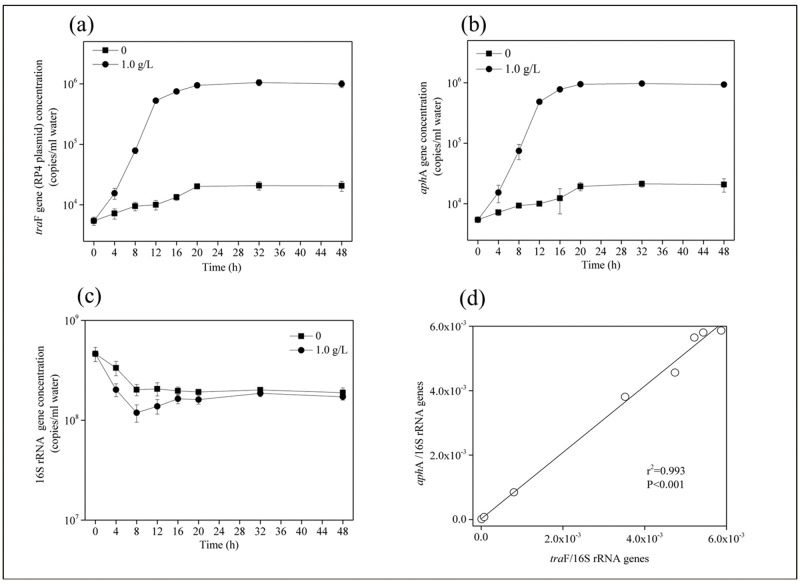
The changes in the traF gene (copies per ml water) (a), aphA gene (copies per ml water) (b), and 16S rRNA gene (copies per ml water) levels (c) as well as the correlation between relative abundance of the aphA (aphA gene /16S rRNA gene) and traF (traF gene /16S rRNA gene) genes (d) in the freshwater microcosms treated with 1.0 g/L [BMIm][PF6].